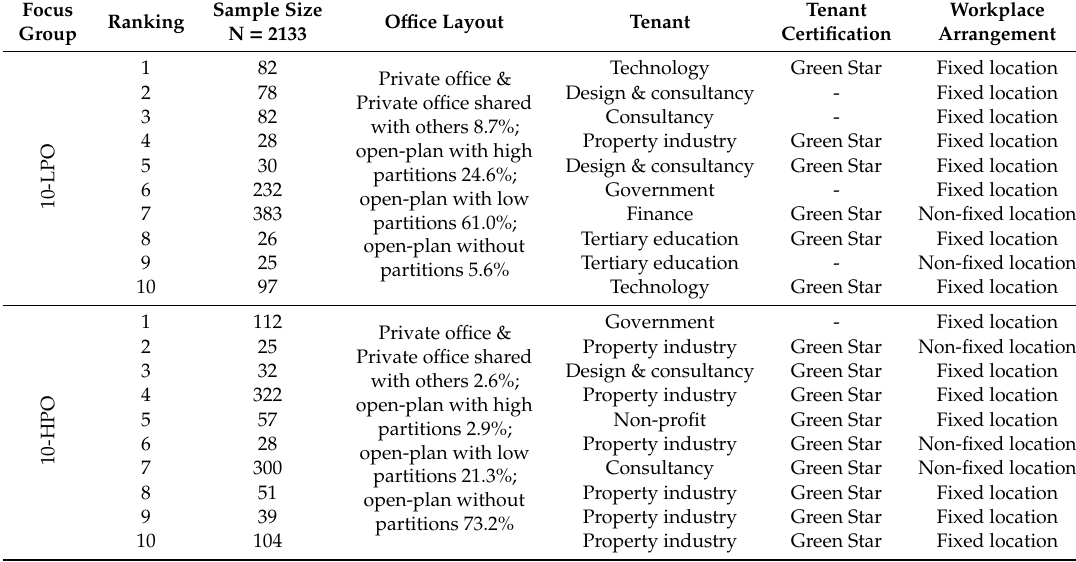
Table 2. Basic information about surveyed o ffi